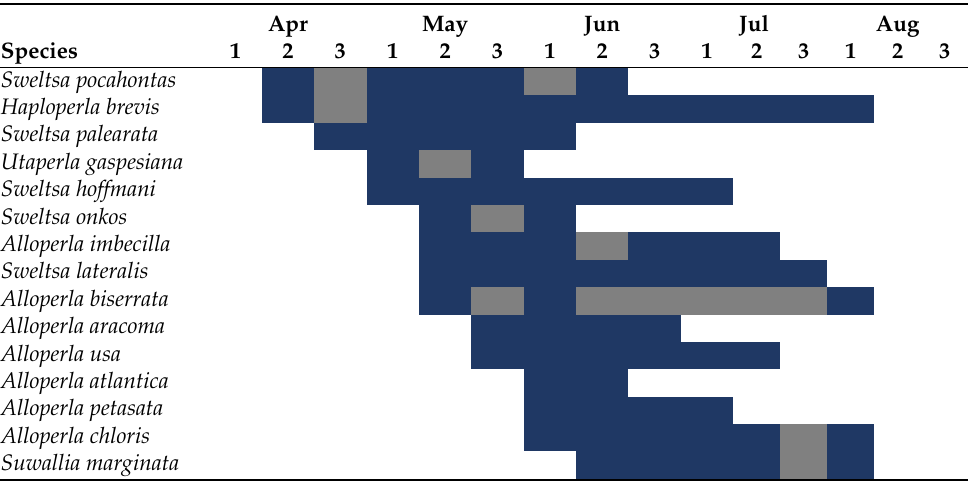
Figure 8. Elevation boxplots for Chloroperlidae species recorded from Maryland. Boxes represent the interquartile range, while vertical lines extend to the minimum and maximum values. The horizontal line within the interquartile range represents the median elevation. Outliers are shown with large, solid circles. Small, individual points overlaid on each boxplot illustrate the distribution of observations. Table 5. Recorded adult Chloroperlidae presence in Maryland. Months are broken into three 10-day periods. Dark blue squares represent periods with collections. Gray squares represent periods when species may be collected.